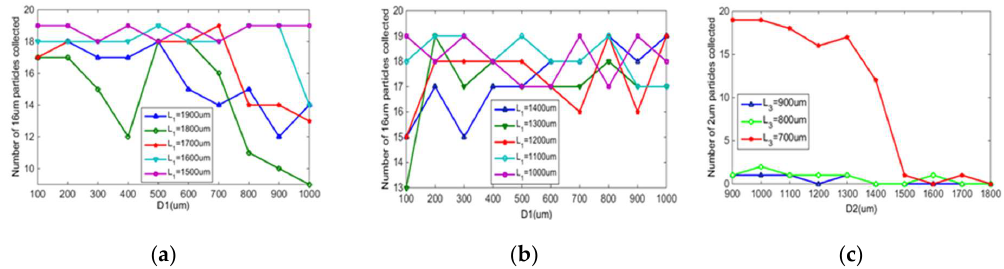
Figure 5. ( a,b ) Relationship between the separation and enrichment effect of 16  m particles and D1; Figure 5. ( a , b ) Relationship between the separation and enrichment e ff ect of 16 µ m particles and D1; ( c ) relationship between the separation and enrichment effect of 2  m particles and D2 . ( c ) relationship between the separation and enrichment e ff ect of 2 µ m particles and D2.